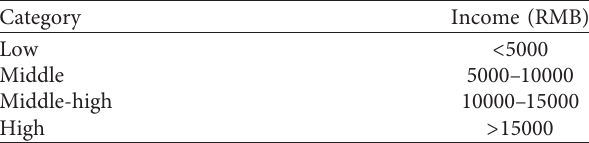
Table 1: Monthly income category in